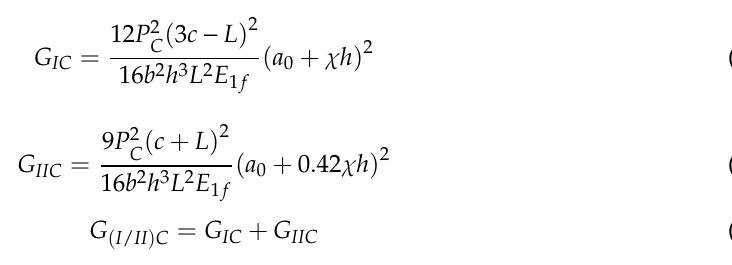
Figure 8. Mixed-mode I/II delamination test setup.